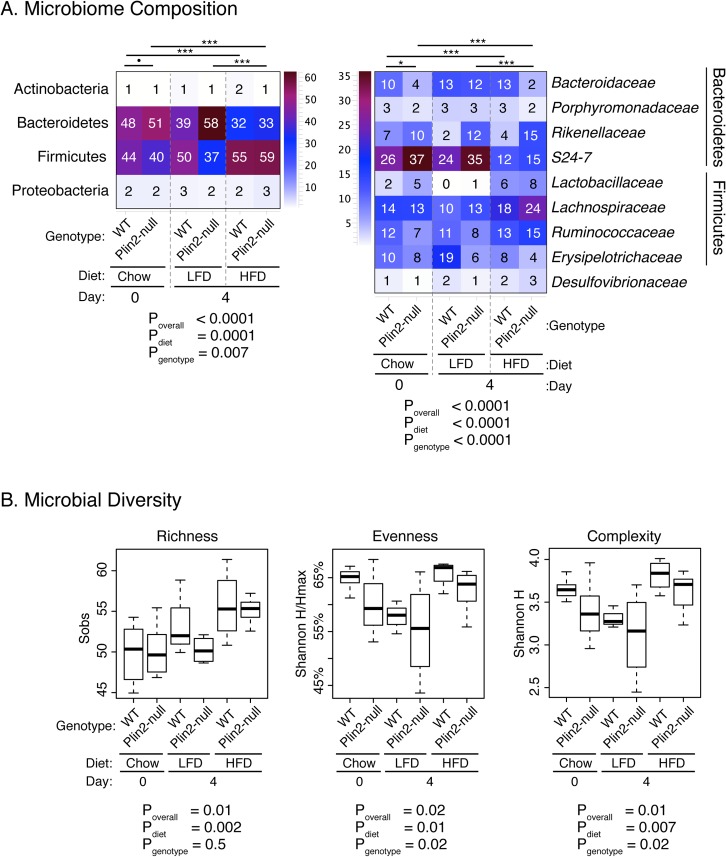
Microbiome composition and biodiversity are altered by genotype and diet.Fecal microbiomes from WT and Plin2-null mice on standard chow, low fat (LF), and high fat (HF) diets were profiled by high-throughput 16S rRNA amplicons sequencing. Panel A displays the distributions of bacteria among phyla (left) and family-level taxonomic categories (right). For simplicity, only taxa with mean relative abundances >2% are displayed; numerical values are the median within-group abundances of taxa. Overall p-values (Poverall) were ascertained by non-parametric PERMANOVA tests for all six diet/genotype groups, using Morisita-Horn dissimilarity scores. PERMANOVA using both diet and genotype as predictor variables was performed to calculate adjusted p-values (Pdiet and Pgenotype). Significant results of pairwise PERMANOVA tests performed on each pair of genotype/diet groups are indicated by horizontal bars above each heatmap: •: p<0.1; *: p<0.05; **: p<0.01; ***: p<0.001. Panel B displays the differences in biodiversity indices (richness, evenness, and complexity) by genotype and diet categories. Overall p-values (Poverall) were ascertained by ANOVA tests for all six diet/genotype groups. ANOVA using both diet and genotype as predictor variables was performed to calculate adjusted p-values (Pdiet and Pgenotype).